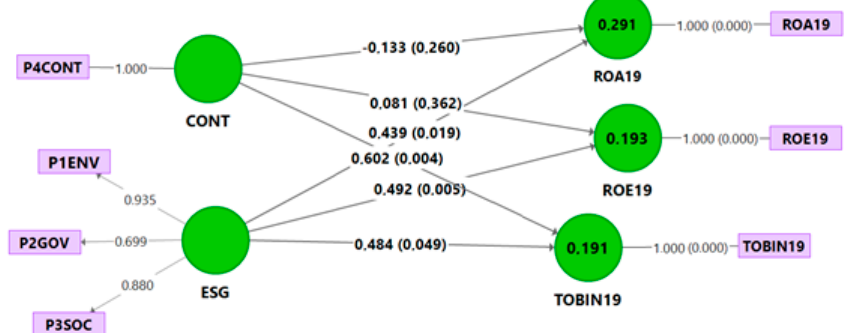
Figure 2. Estimated model (direct effect). Source: [76]. Note: Values in brackets refer to p -values.